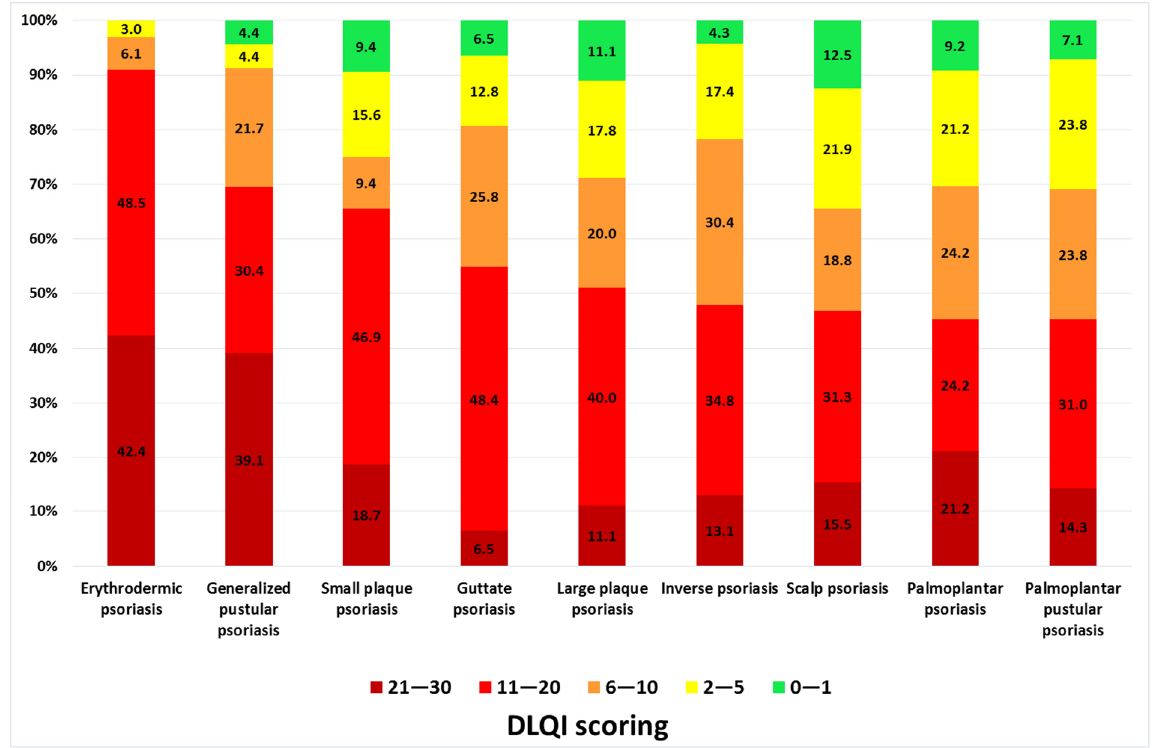
Figure 2. Degree of psoriasis impact on quality of life based on Dermatology Life Quality Index (DLQI) scoring in various clinical variants of psoriasis (0–1—no effect, 2–5—small effect, 6–